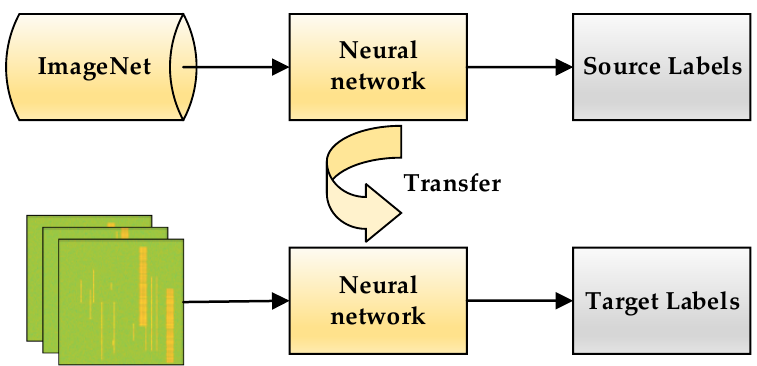
Figure 8. Schematic diagram of transfer learning method.